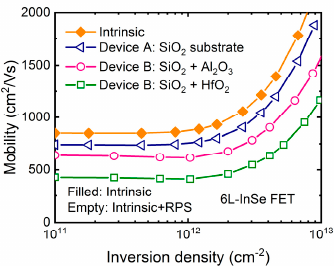
Figure 3. Calculated mobility as a function of inversion density in six ‐ layer InSe FETs with different device structures as shown in Figure 1a,b utilizing Al 2 O 3 and HfO 2 as top ‐ gate dielectric and SiO 2 substrate as back ‐ gate dielectric respectively. Equivalent oxide thickness (EOT) = 1 nm of high ‐ κ dielectric is assumed. Filled symbols represent intrinsic phonon ‐ limited mobility for benchmark, while empty symbols represent total mobility including the remote phonon scattering from substrate and high ‐ κ dielectric.